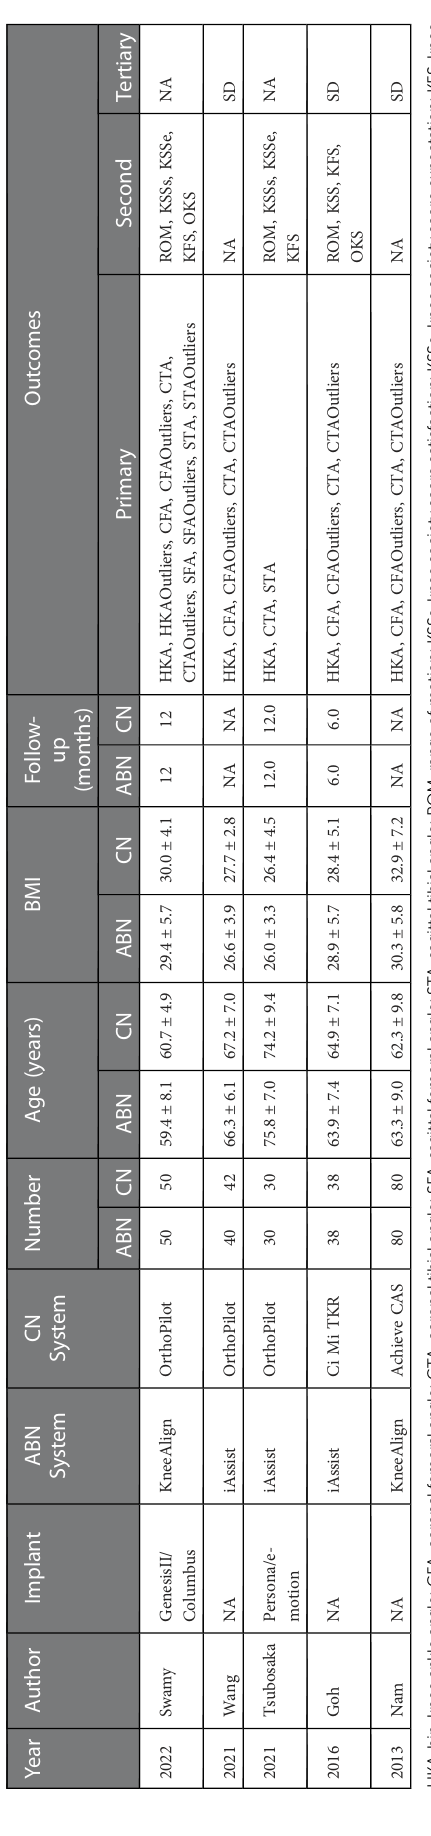
Fourteen studies reported the postoperative hip-knee-ankle (HKA) angle when using the ABN system or CONI approach. The results suggest that the ABN system allows for more accurate lower limb alignment ( Figure 3A , MD: − 0.64, 95% CI: − 0.92 to − 0.35, P < 0.0001, I 2 = 59%). The results of fi ve studies comparing the HKA when using the ABN and CN systems did not show any signi fi cant difference between the two alignment techniques ( Figure 3B , MD: − 0.26, 95% CI: − 0.55 to − 0.04, P = 0.08, I 2 = 0%). T